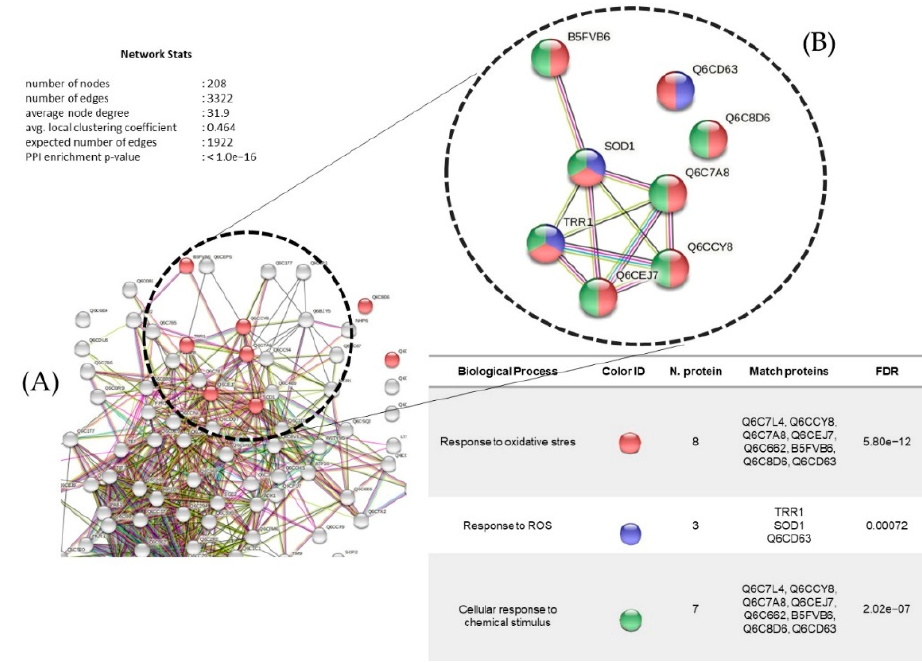
Figure 13 . ( A ) Protein interaction networks (upregulated) of Y. lipolytica AMJ6 related to biological processes under copper (Cu +2 ) treatment. ( B ) Proteins related to the response to oxidative stress, cellular response to chemical stimulus, and response to ROS.